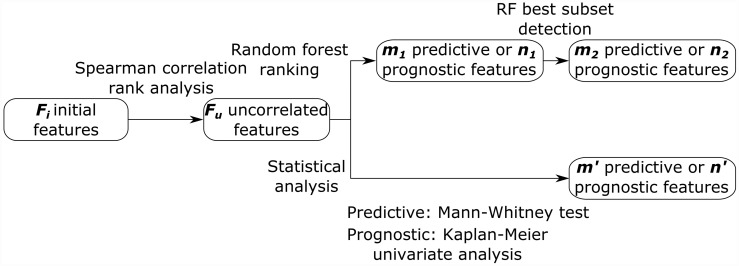
Workflow of the feature selection strategy and data analysis.